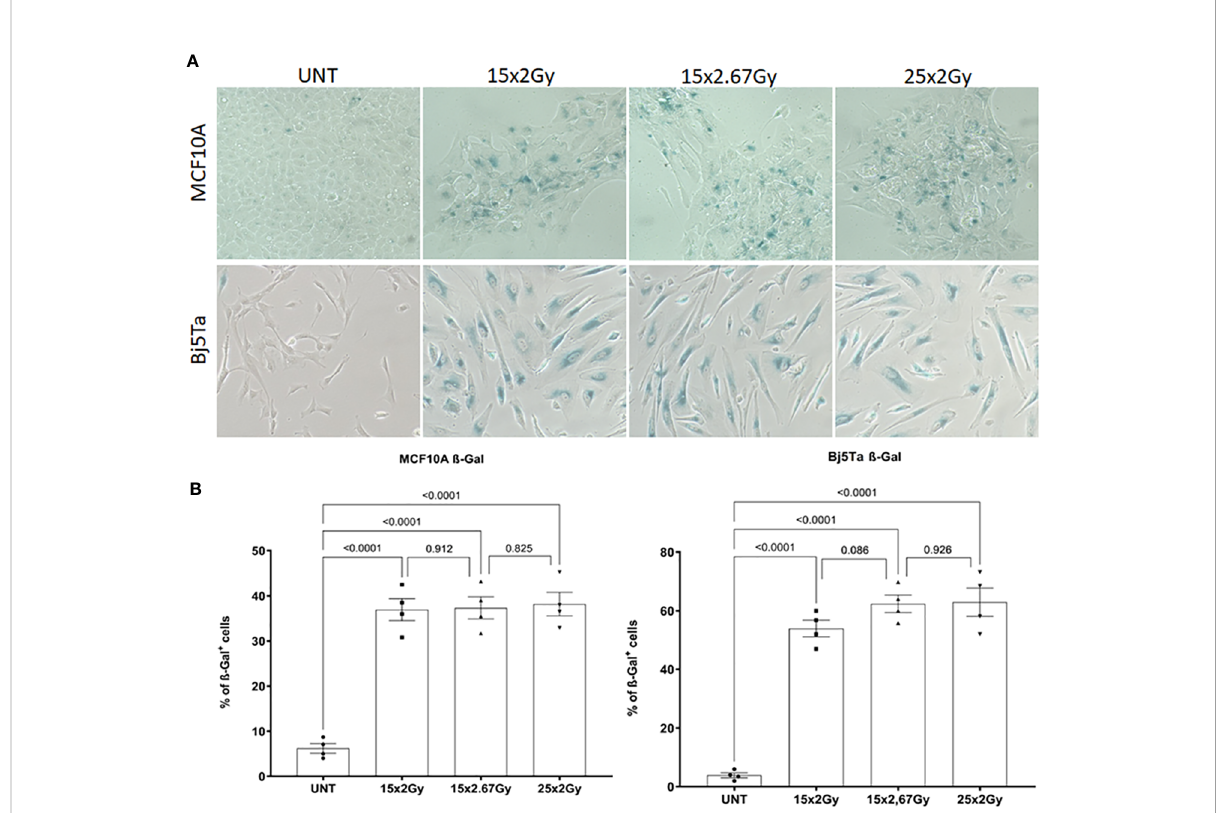
FIGURE 5 Senescence-associated beta-galactosidase (SA- b gal) activity analysis in MCF10A and Bj5Ta cells after fractionated irradiation with the corresponding protocols. Representative images of SA- b gal staining (A) and evaluation (B) of the percentage of senescent cells using inverse microscopy (Nikon Eclipse TS100 data from two technical replicates are presented as bar plots). Each dot represents a counting area (UNT – untreated “ age-matched ” to day